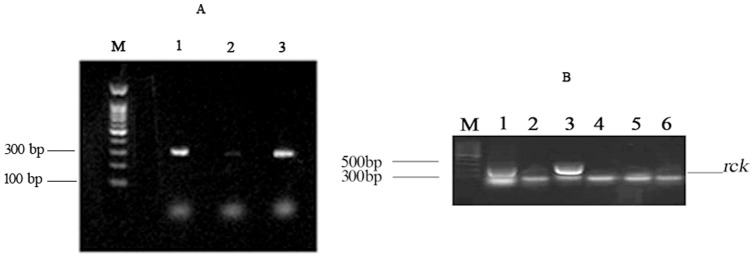
The locus of rck and its expression.(A) PCR of rck gene in pRST98. M: 1000 bp DNA ladder; Lane 1: S. Typhi ST8; Lane 2: S. Typhi ST8-ΔpRST98; Lane 3: S. Typhi ST8-c-pRST98. (B) The effect of AHLs on the expression of the rck gene. M: 1000 bp DNA ladder; Lane 1: S. Typhi ST8 treated with AHLs; Lane 2: S. Typhi ST8 treated with saline; Lane 3: S. typhi ST8-c-pRST98 treated with AHLs; Lane 4: S. Typhi ST8-c-pRST98 treated with saline; Lane 5: S. Typhi ST8-ΔpRST98 treated with AHLs; Lane 6: S. Typhi ST8-ΔpRST98 treated with saline.